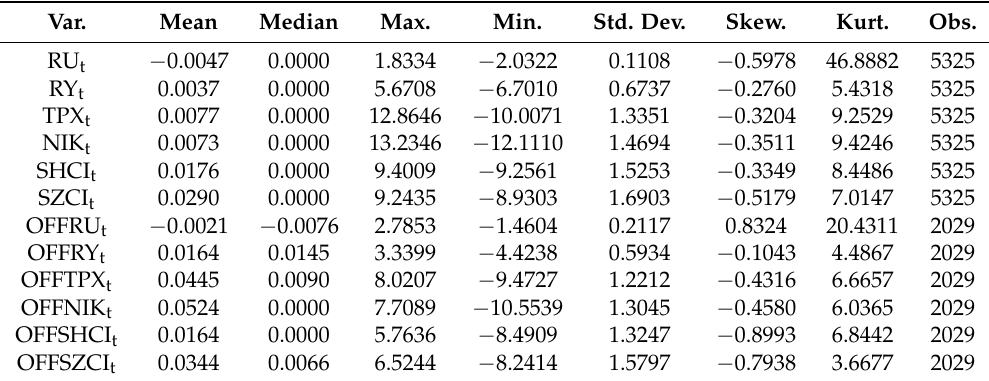
Table 1. Descriptive statistics of stock returns and exchange rate changes. Var. Mean Median Max. Min. Std. Dev. Skew. Kurt.